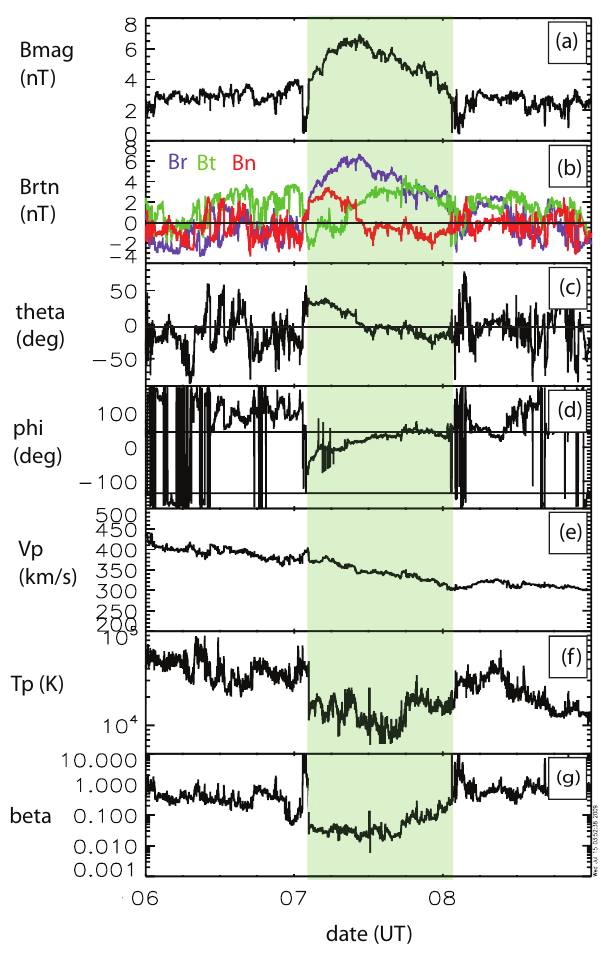
Fig. 8. STA in-situ observations on 6–9 November 2008. The green-hatched area shows the ICME interval. The panels show: (a) magnetic field magnitude, (b) RTN components of the mag- netic field, (c) magnetic field latitude, and (d) longitude in RTN, (e) solar wind speed, (f) proton temperature and (g) plasma beta. Two horizontal lines ( φ = 45 ◦ and φ =− 135 ◦ ) in panel (d) indicate the division to away ( φ within − 135 ◦ − 45 ◦ ) and toward magnetic